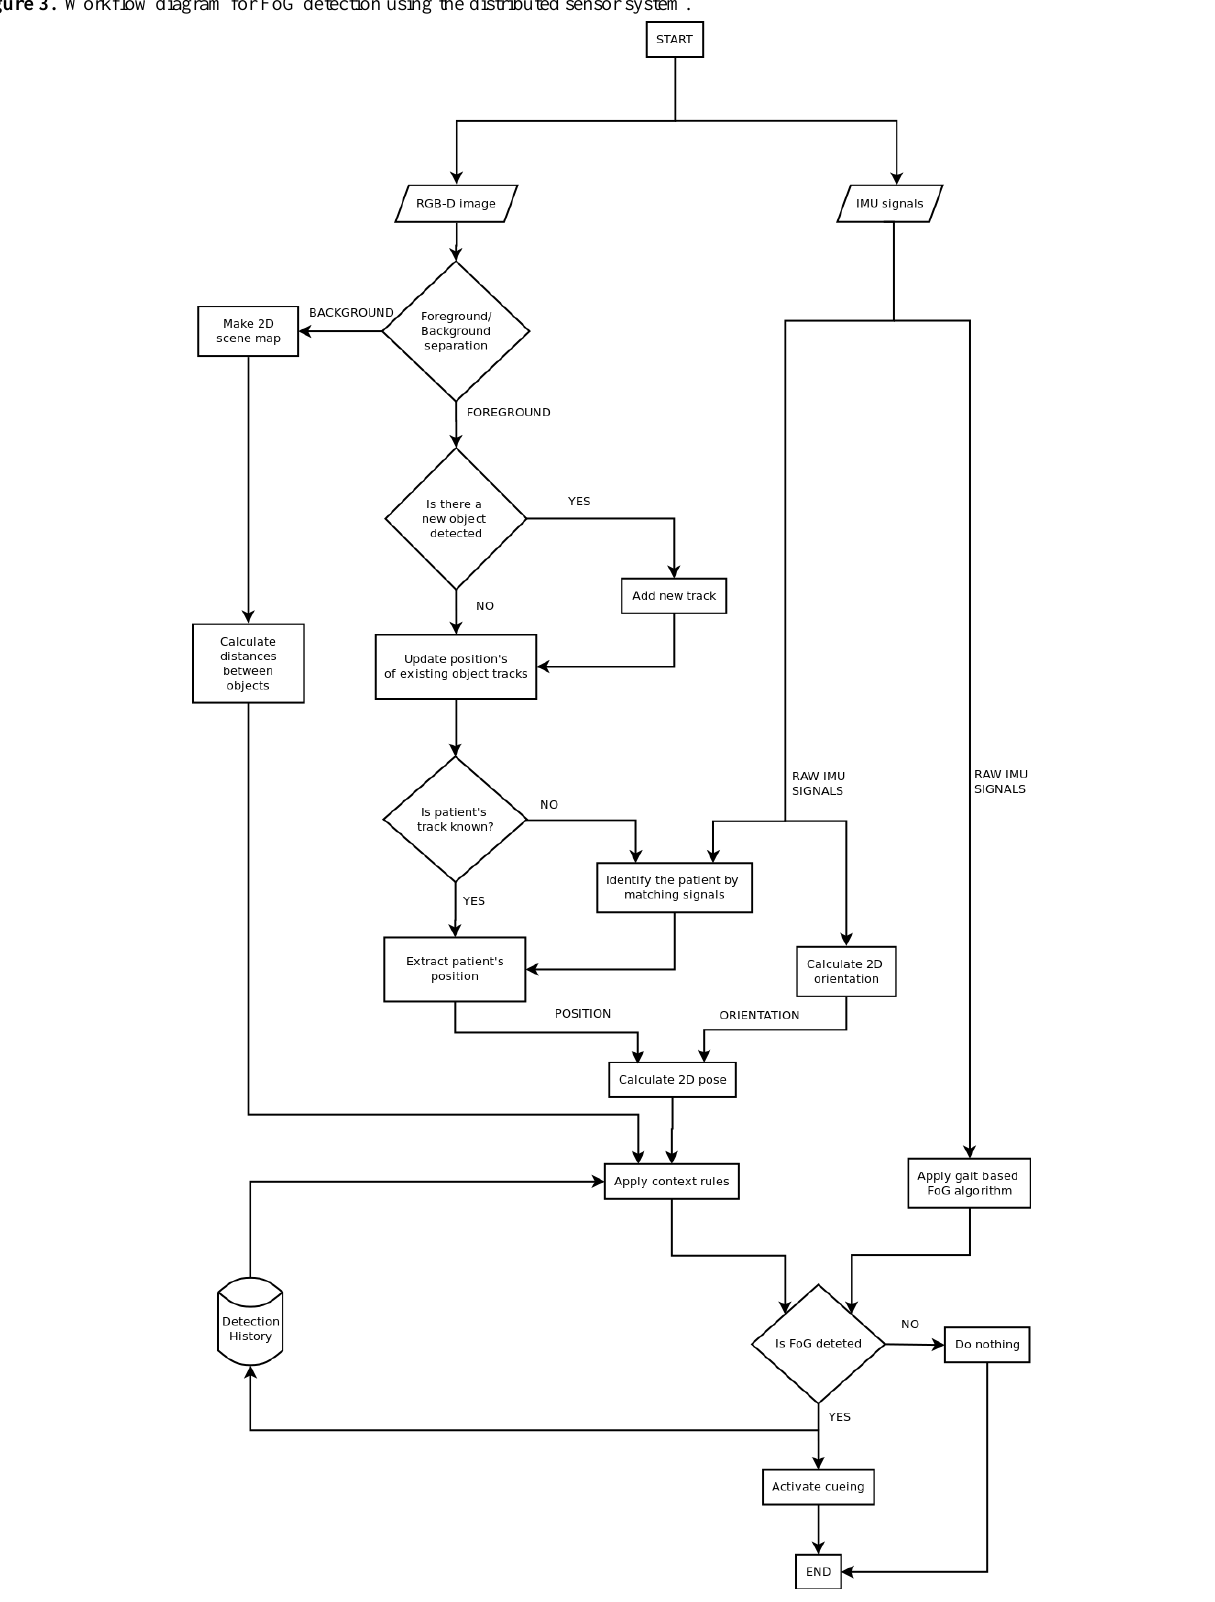
Figure 3. Workflow diagram for FoG detection using the distributed sensor